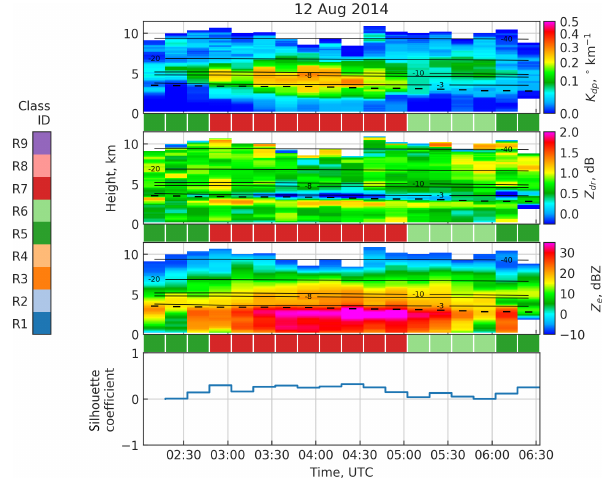
Figure 7. Classification analysis of a rain case with silhouette scores. The automatically detected melting layer is marked with a dashed line, the solid lines show the NCEP GDAS temperature con- tours and the colors between the panes denote classification results. Figure 8. Classification analysis of a snow case with silhouette scores. Solid lines show the NCEP GDAS temperature contours and the colors between the panes denote classification